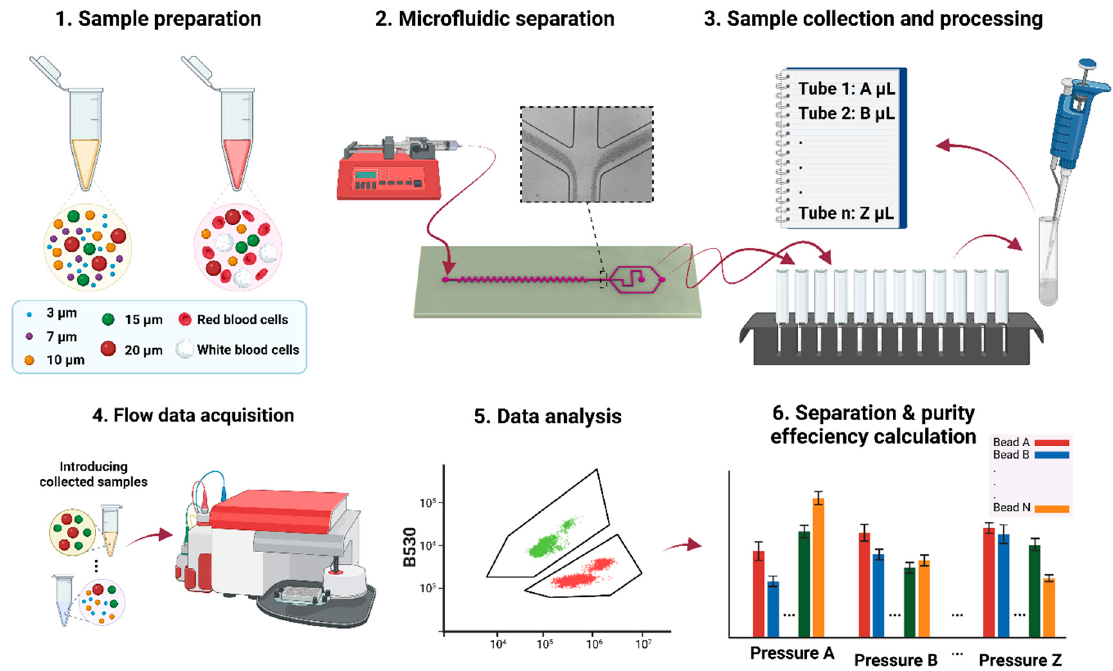
Figure 1. Overview of the method to quantitatively assess the performance of microfluidic sorting devices using flow cytometry. This method is a 6-step process involving sample preparation, microfluidics separation, sample collection and processing, flow data acquisition, data analysis, and the calculation of the quantitative metrics. Together, this allows a robust and quantitative way to assess the performance of any continuous flow microfluidic device that enables particle separation.